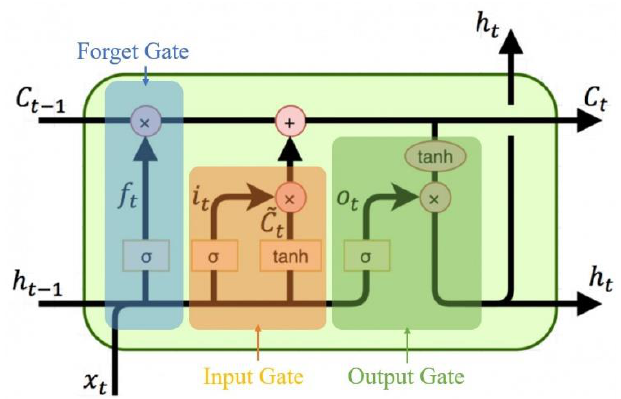
Figure 1. LSTM architecture comprises four